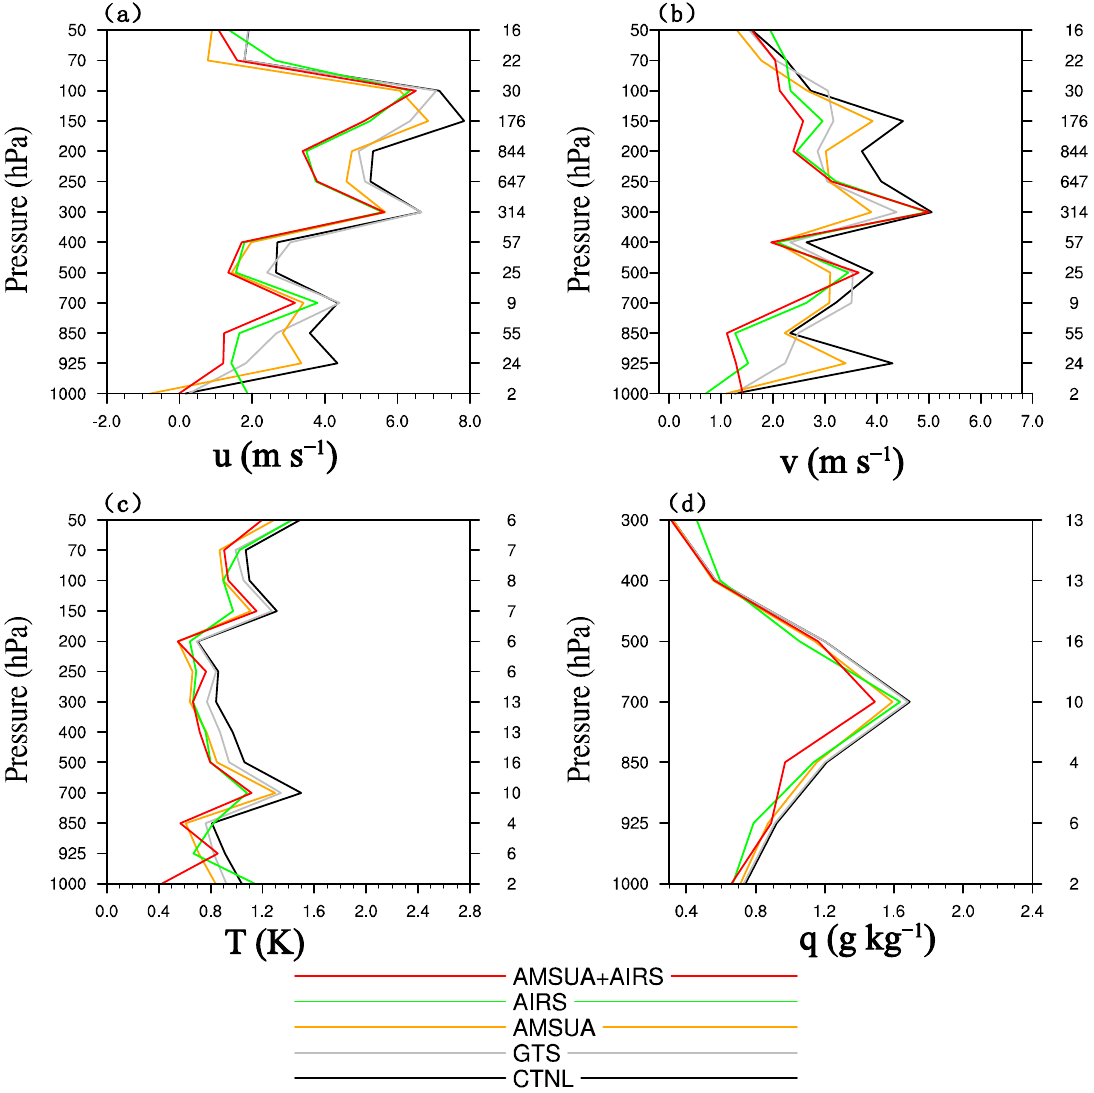
Figure 7. RMSE mean values including ( a ) U wind speed (unit: m / s), ( b ) V wind speed (unit: m / s), ( c ) temperature (unit: K), and ( d ) humidity field (unit: g / kg) of all experiments at the analyzed time.